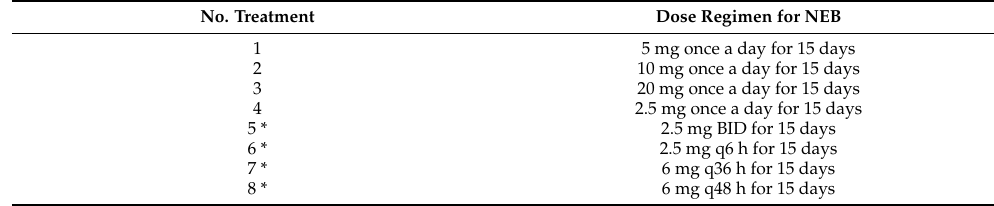
Table 1. NEB dosing regimens